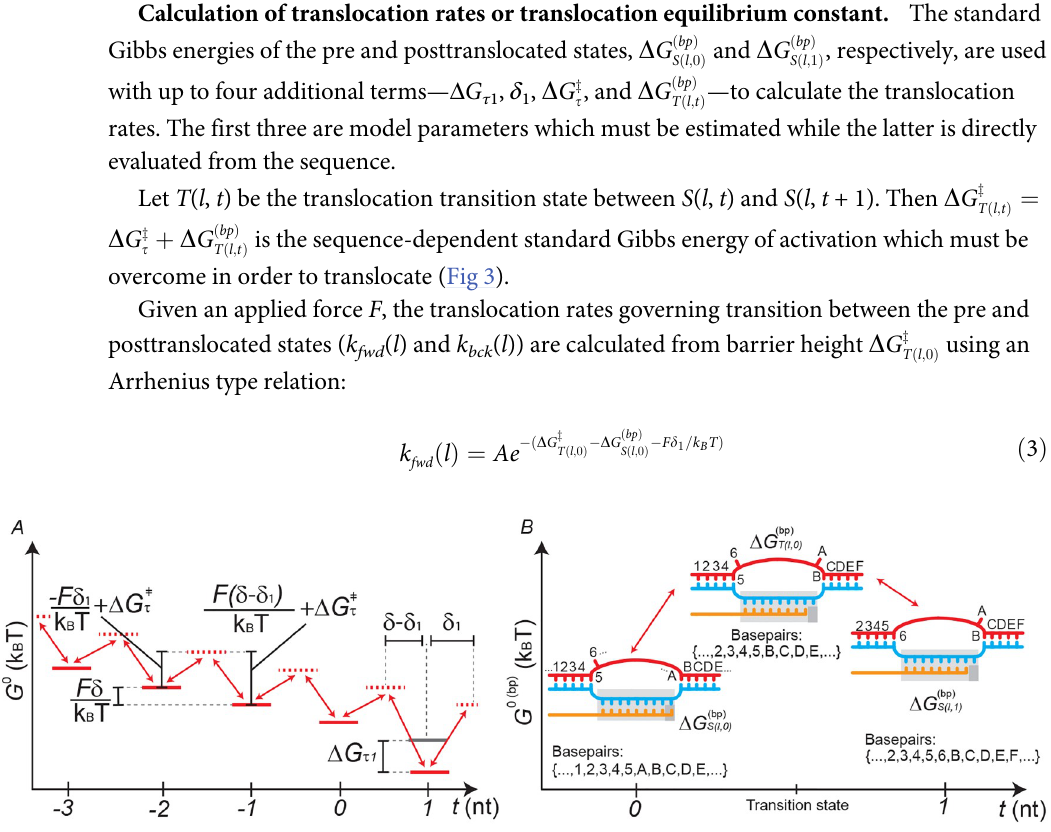
Fig 3. Parameterisation of the translocation step. (A) Effects of model parameters on state energies. The figure displays a schematic Gibbs energy landscape of translocation, with backtracked states included for visualisation purposes. The solid red lines represent translocation states ( t = 0: pretranslocated, t = 1: posttranslocated, and t < 0: backtracked), while the dashed red lines represent transition states. Applying an assisting force F > 0 tilts the landscape in favour of higher values of t . The effect of Δ G τ 1 is observed at the posttranslocated state t = 1. In a translocation equilibrium model, the barrier height is assumed to be so small, = translocation is so rapid, that the transition states are disregarded. (B) A model for the sequence-dependent transition state between translocation states S ( l , 0) and S ( l , 1). This is required for estimating the Gibbs energy of basepairing D G ð bp Þ in the transition state. T ð l ; t Þ , together specify the height of the activation barrier (Eq The basepairing energy, added to a baseline term D G z t